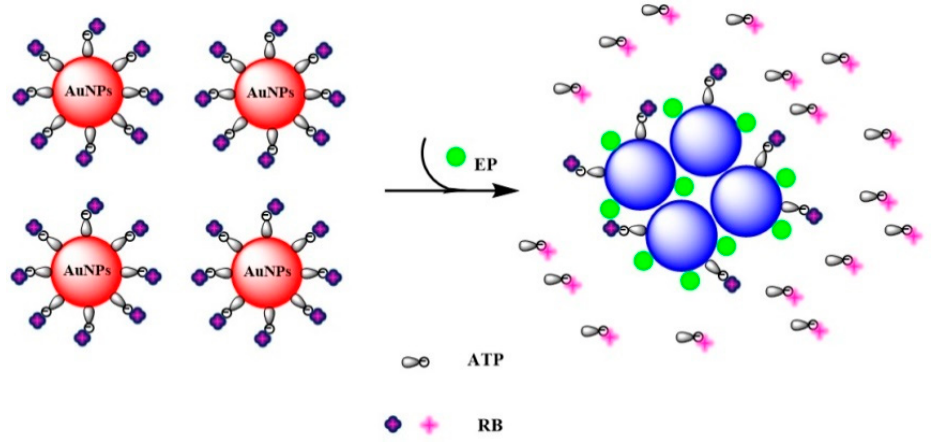
Scheme 1. The proposed mechanism of colorimetric and fluorescence detection for ethoprophos using